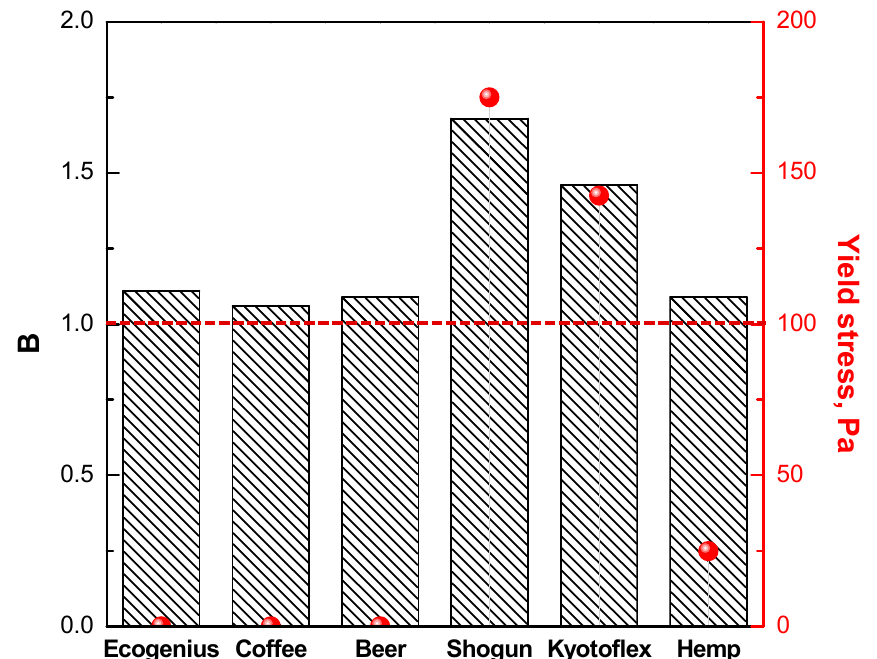
Figure 5. Calculated die swell (bars) and yield stress values (red symbols) for all investigated PLA-based filaments.